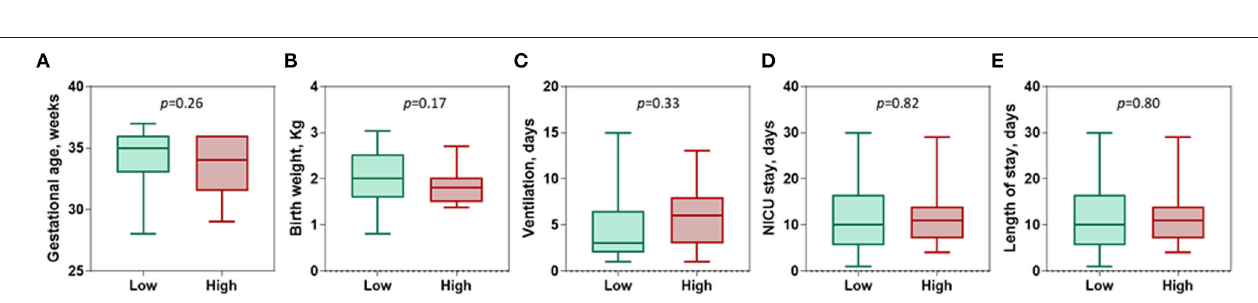
FIGURE 2 | The relative expression level of circulatory C1INH gene. (A) The log fold change of C1INH gene in neonatal lung disease patients ( n = 94) compared to matched controls ( n = 45). The expression level was estimated using the LIVAK method and log-transformed. Mann-Whitney U -test was used. p -value was < 0.001. (B) Comparison between the expression level of C1INH in neonatal lung disease patients with G/G ( n = 47), A/G ( n = 18), and A/A ( n = 29) genotypes of rs4926 missense mutation (c.1438G > A; V480M). Kruskal-Wallis test was used. p -value was < 0.001. (C) Comparison between the expression level of C1INH in neonatal lung disease patients with ( n = 52) and without ( n = 42) sepsis. Mann-Whitney U -test was used. P -value was 0.0114.